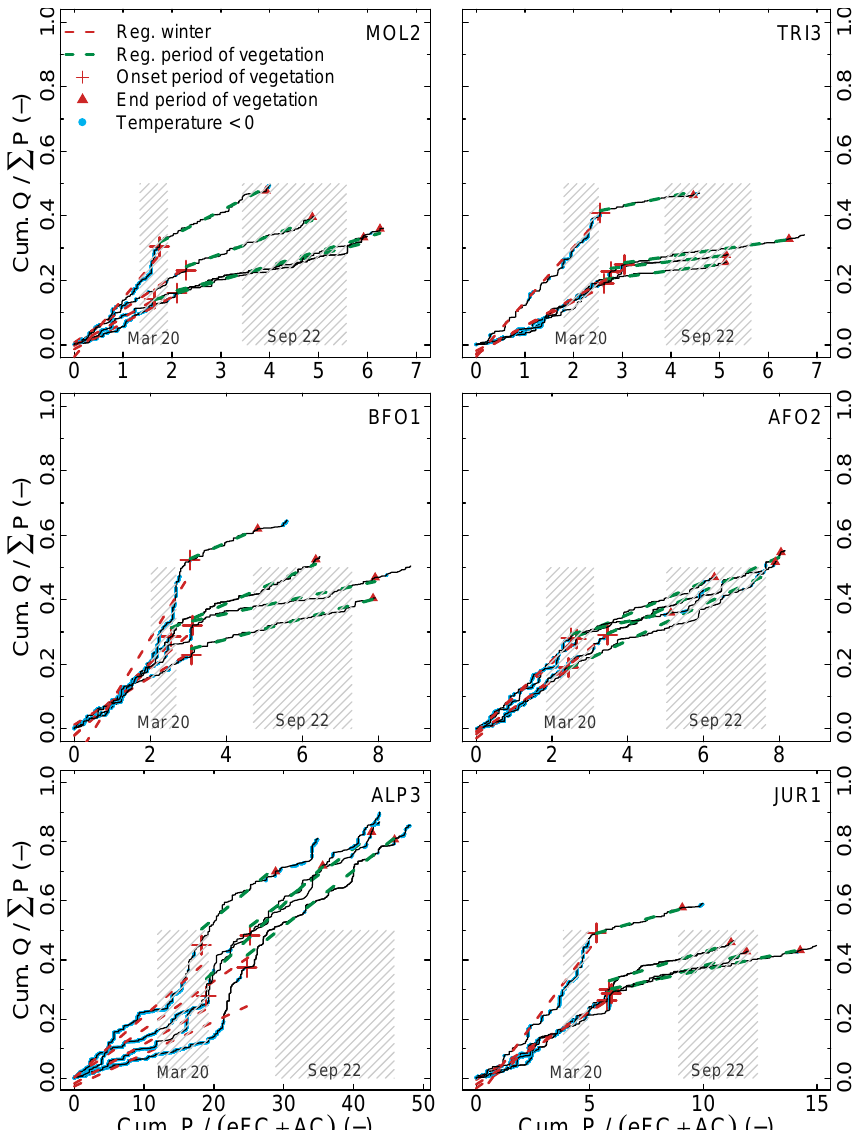
Figure 5. Type II dimensionless double mass curves for six catchments of different geological units. The dDMC depicted here are the same as those depicted in Fig. 4 but with the difference that the abscissa is scaled using the sum of average effective field capacity (eFC) and air capacity (AC). All other properties are analogous to Fig.